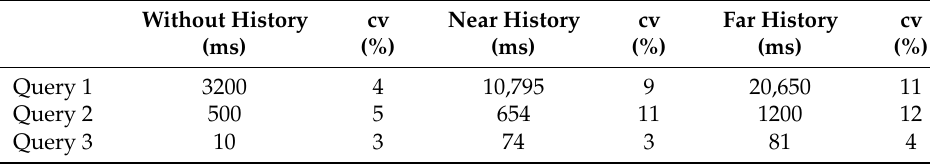
Table 5. Approach II: Query performance.